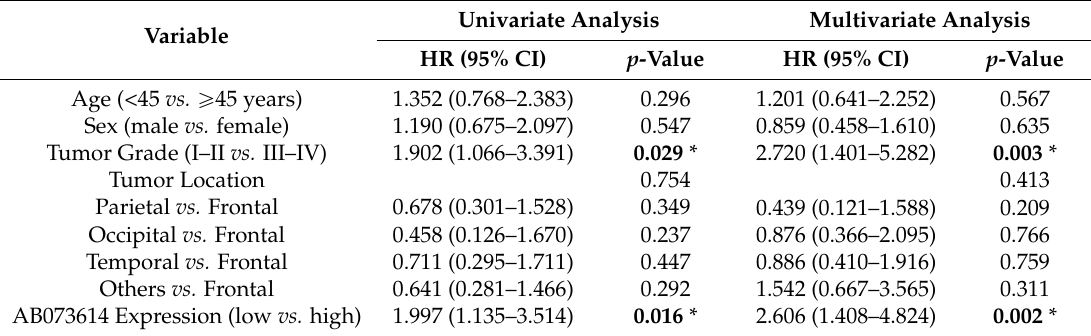
Table 2. Univariate and multivariate analyses of different clinicopathological variables and lncRNA AB073614 expression. Univariate Analysis Multivariate Variable